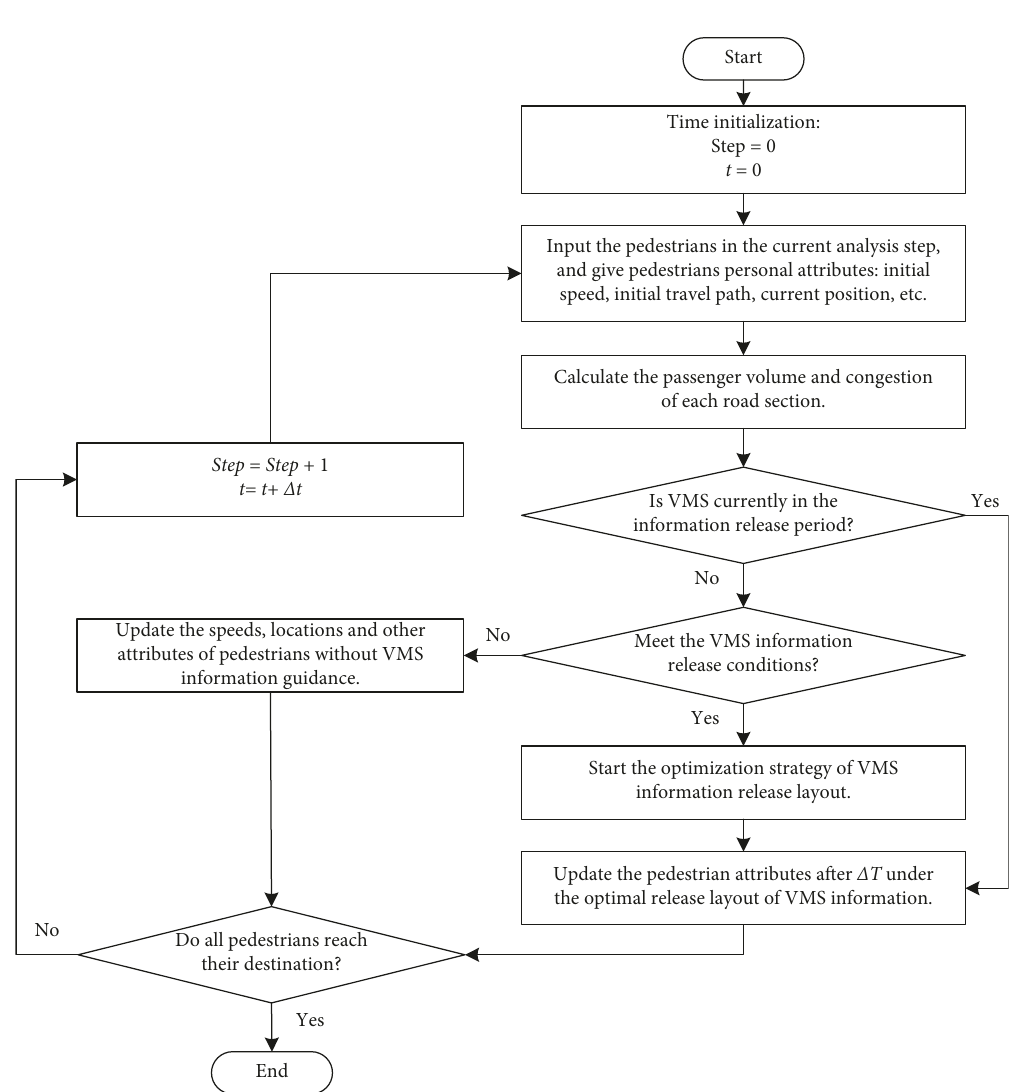
Figure 5: The overall simulation process of pedestrian travel for the scenario with VMS information release strategy.